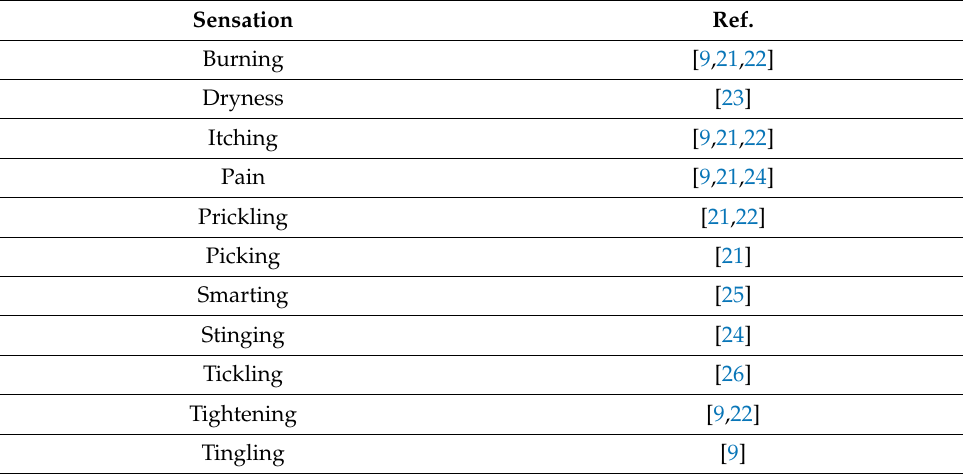
Table 1. Examples of unpleasant sensations experienced by individuals with